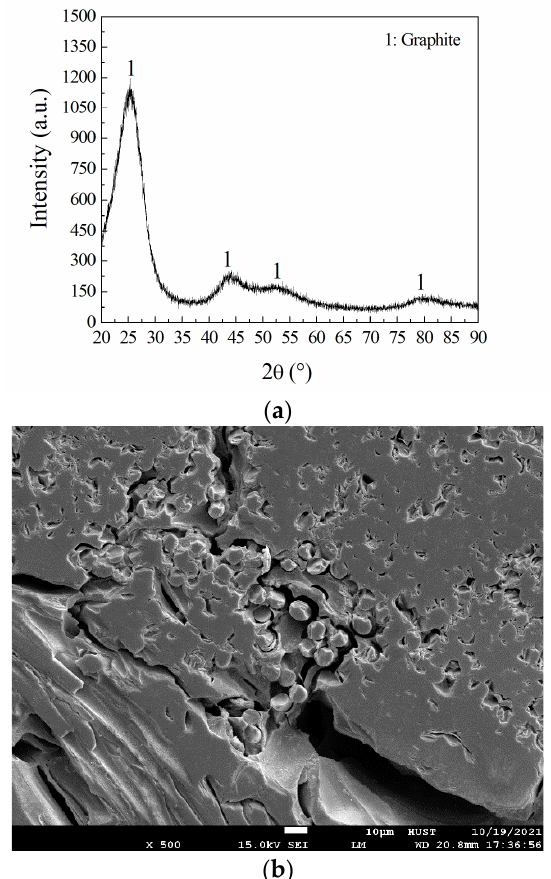
Figure 1. XRD pattern and SEM morphology of C/C composites. ( a ) XRD pattern; ( b ) SEM